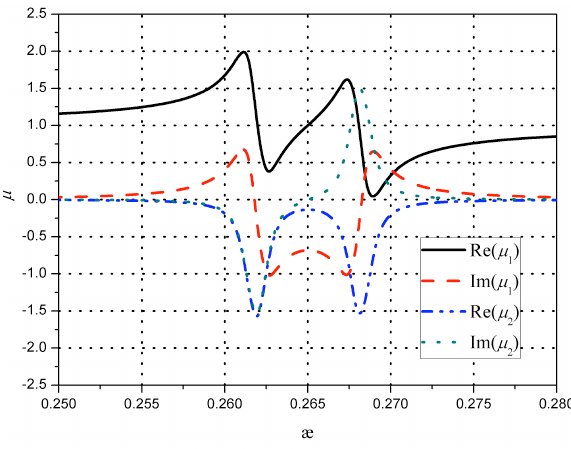
Figure 8. Dispersion curves of the permeability tensor components of the antiferromagnetic film for H